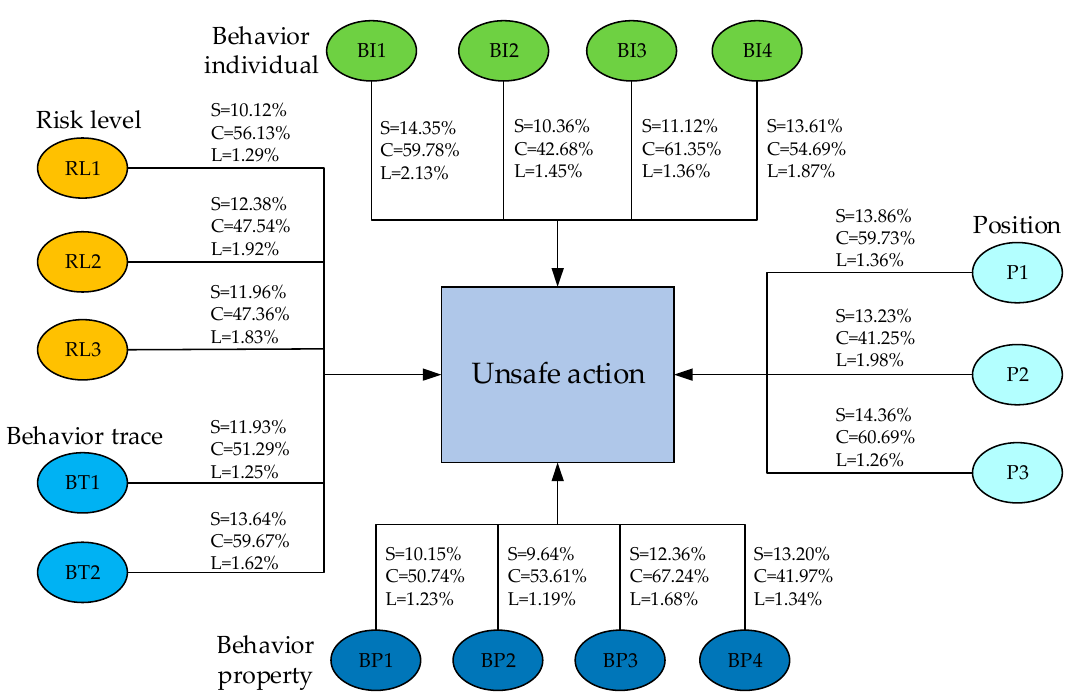
Figure 2. Association rule results of the miners’ unsafe Figure 2 . Association rule results of the miners’ unsafe behavior.